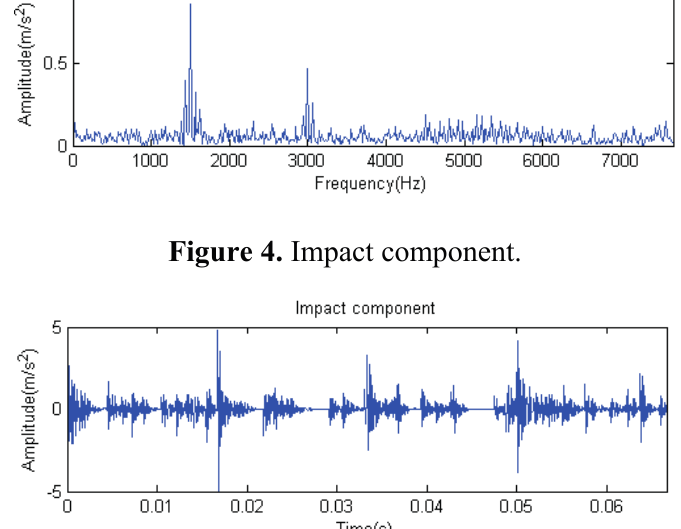
Figure 5. Fourier component.